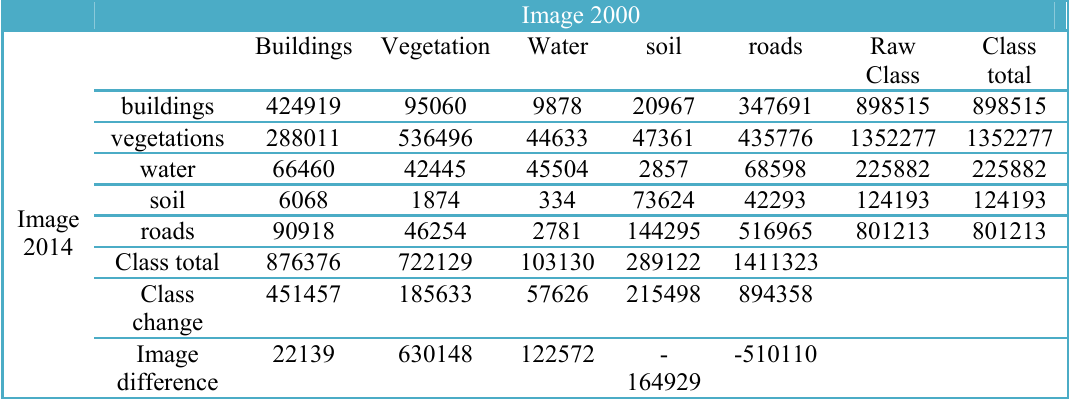
Table 4: The area of the initial and final classes using kilometer unit. Image 2000